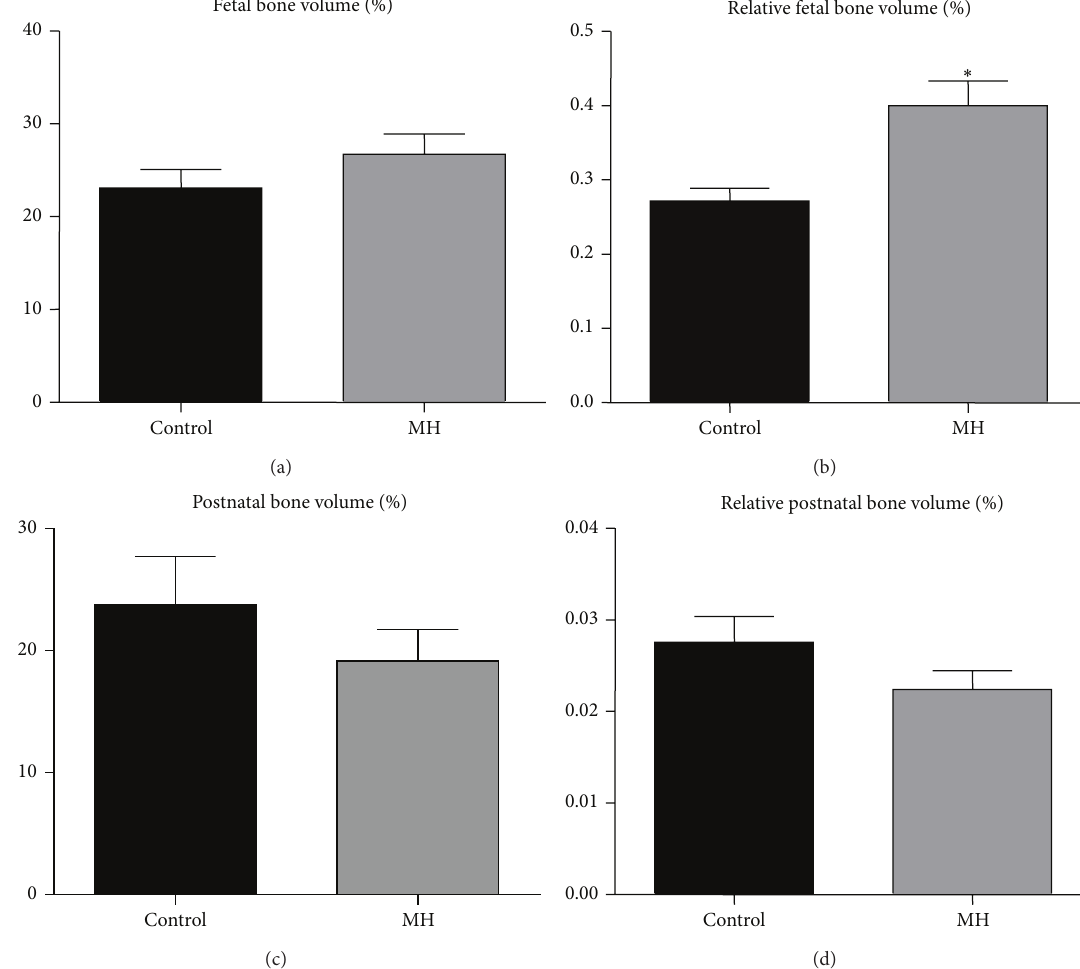
Figure 4: Effects of MH on tibial trabecular bone volume as measured by histomorphometry (BV/TV, %). (a) BV/TV of fetal bones from control and hypoxia-treated mothers. (b) Relative BV/TV (adjusted for total body weight) in fetal guinea pigs (%/g). (c) BV/TV of bones of 120d postnatal guinea pigs from control and hypoxia-treated mothers. (d) Relative BV/TV in postnatal guinea pigs (adjusted for total body weight, %/g). ( 𝑛 = 5 , ∗ 𝑃 < 0.05 when compared to